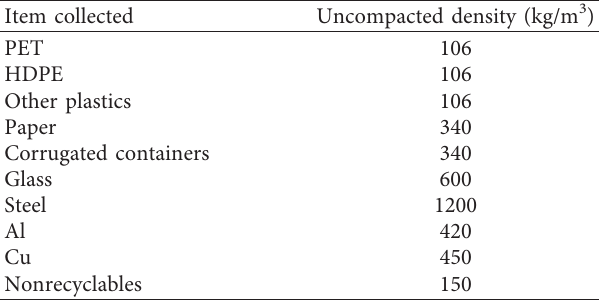
Table 2: Truck load composition and uncompacted volume (for the kg of recyclables collected on a route).